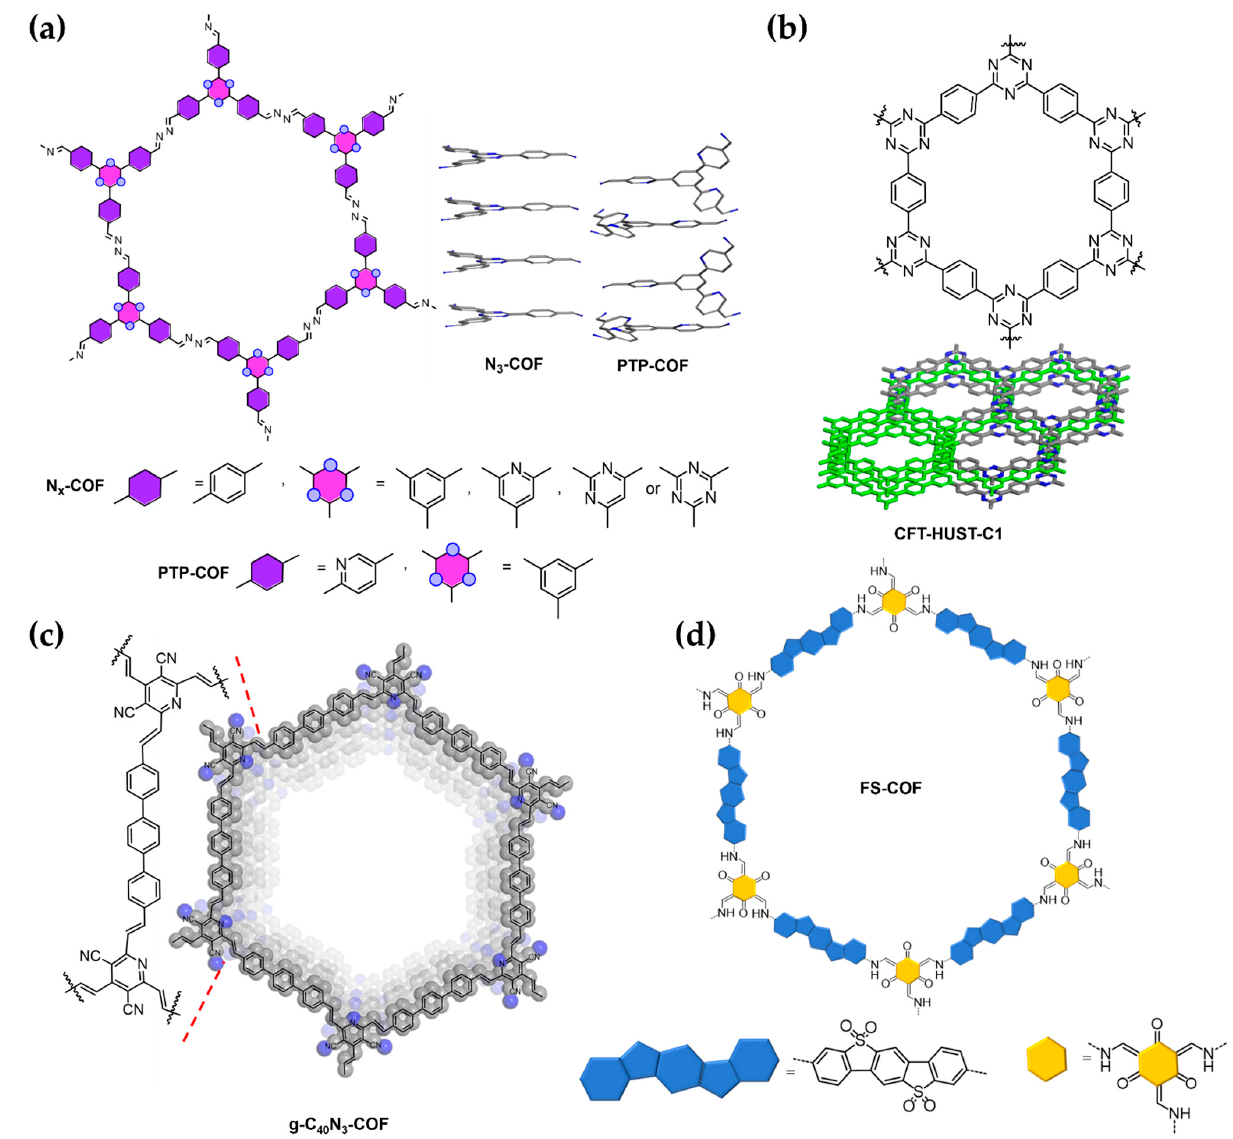
Figure 4. Highly crystalline N x -COFs (x = 0–3) and the PTP-COF [19] ( a ), CTF-HUST-C1 [20] ( b ), the g-C 40 N 3 -COF [28] ( c ), and the FS ‐ COF [24] ( d ). The π‐ stacking interactions in the N 3 ‐ COF and PTP ‐ COF are also displayed in ( a ).